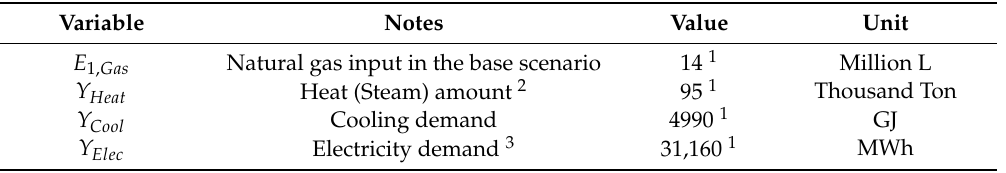
Table 4. Data for energy input and energy service.